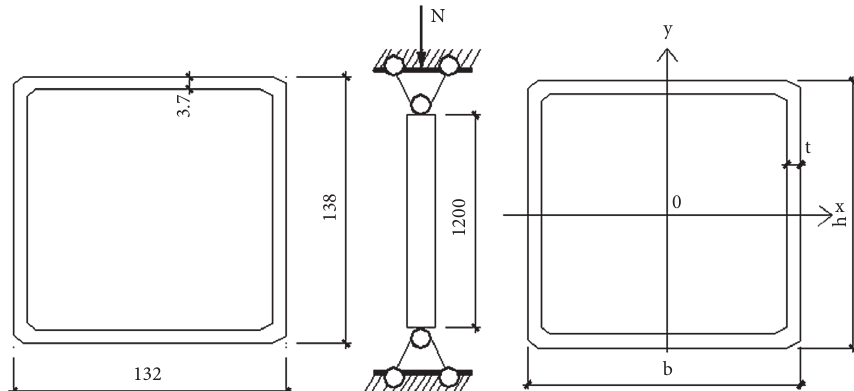
Figure 30: ZF-type section.